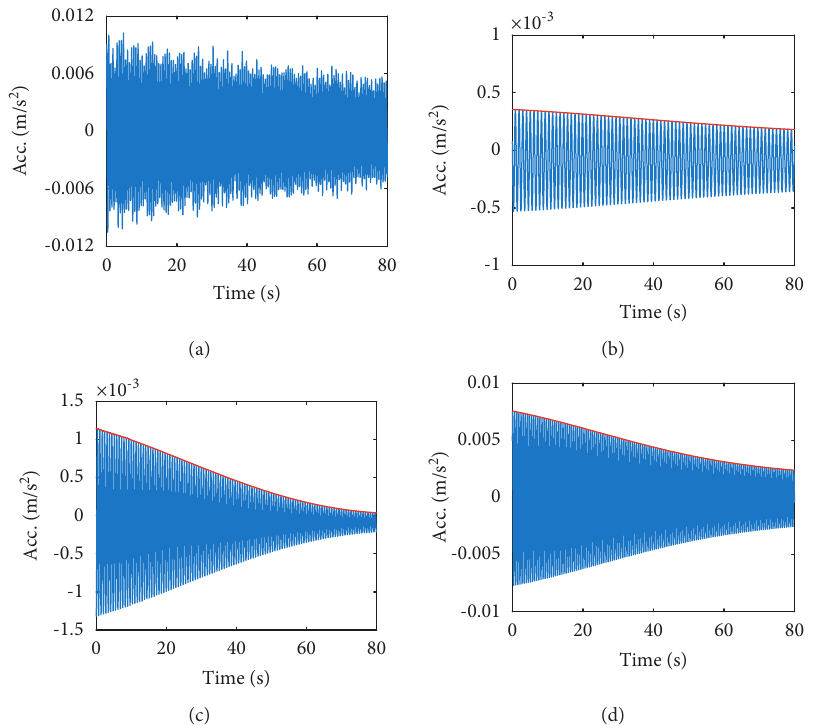
Figure 8: Free decay response of the bridge. (a) Overall response, (b) 0.8 ∼ 0.96 Hz, (c) 1.4 ∼ 1.5Hz, and (d) 1.58 ∼